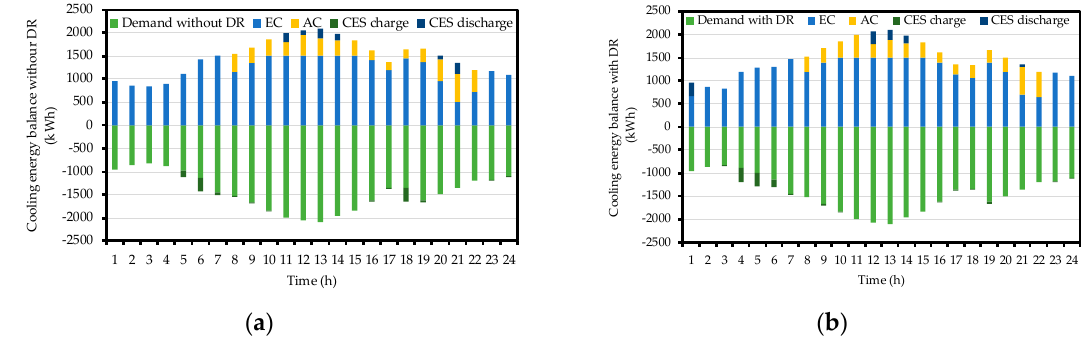
Figure 12. Optimal scheduling results for cooling: ( a ) without DR; ( b ) with DR.